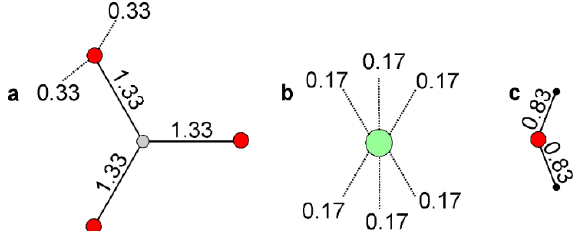
Figure 8. The bond-valence structure of the interlayer ( a ) carbonate group (C = grey; O = red), ( b ) Cl − anions (Cl green) and ( c ) water molecules in LDHs (O = red; H = black), with the individual bond valences shown in valence units (v.u.).